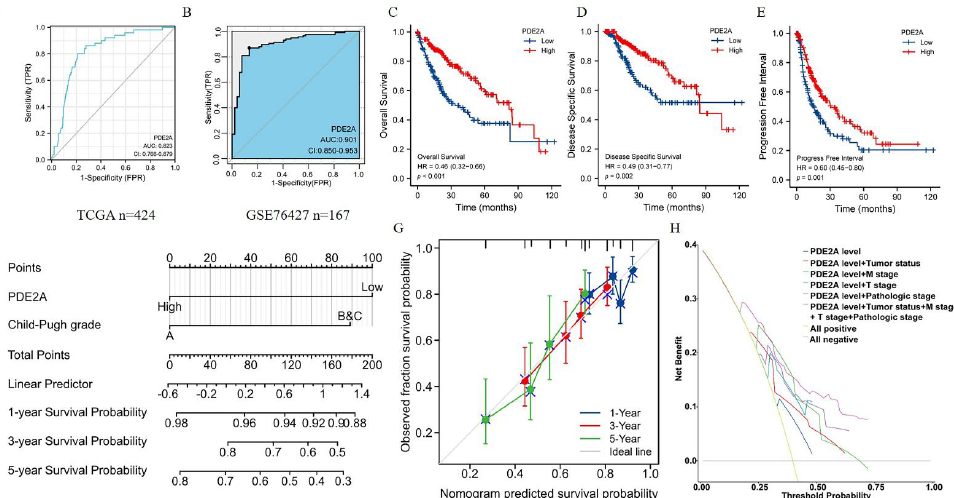
Figure 5. Predictive value of PDE2A expression for diagnosis and clinical outcomes in HCC patients. Receiver operating characteristic (ROC) curve analysis evaluating the performance of PDE2A for HCC diagnosis based on TCGA database ( A ) and GSE76427 database ( B ). ( C – E ) Kaplan–Meier analyses comparing overall survival ( C ), disease-specific survival ( D ), and progression-free interval ( E ) between high- and low-PDE2A expression groups. ( F – G ) Nomograms constructed to establish PDE2A expression-based risk scoring models for 1-, 3-, and 5-year overall survival. ( H ) Decision Curve Analysis (DCA) for the PDE2A expression, tumor status, M stage, T stage, and pathologic stage risk prediction